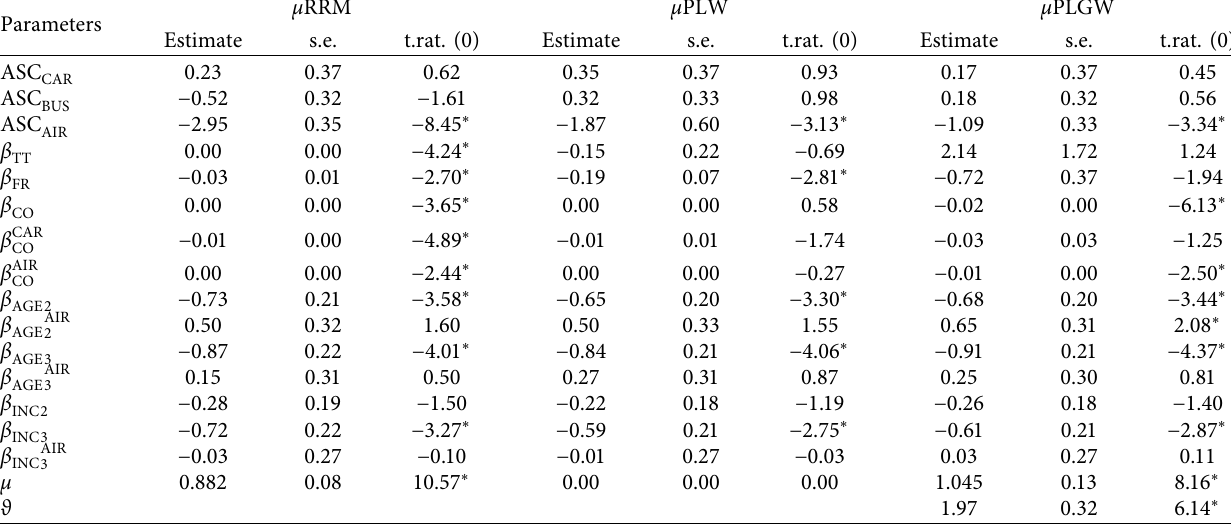
Table 11: Estimates of the μ RRM, μ PLW, and μ PLGW for nonbusiness purpose of the CR experiment.